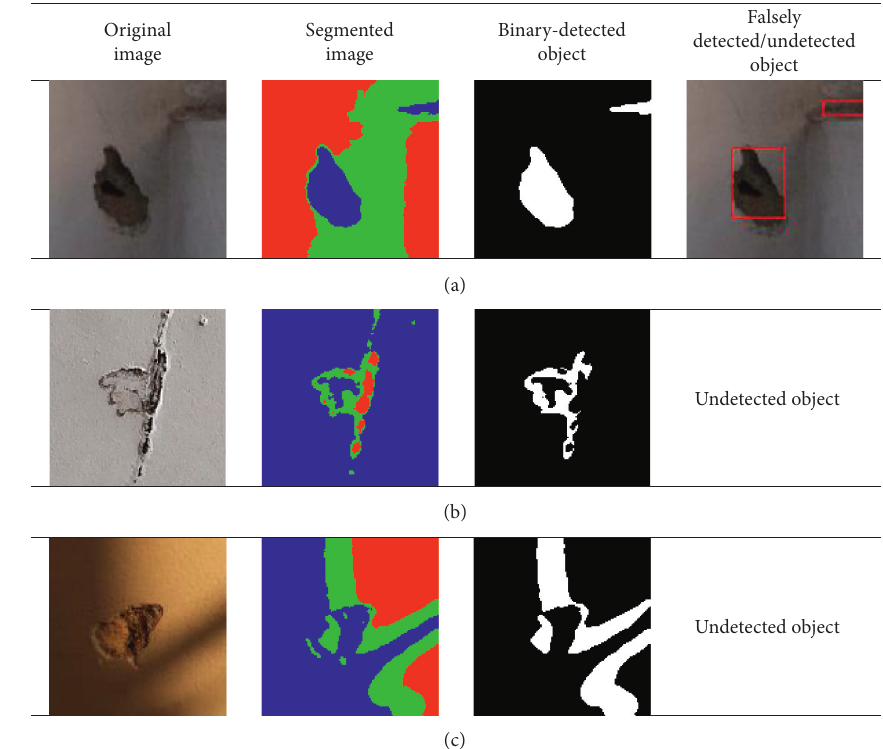
Figure 13: Illustrations of incorrectly classified